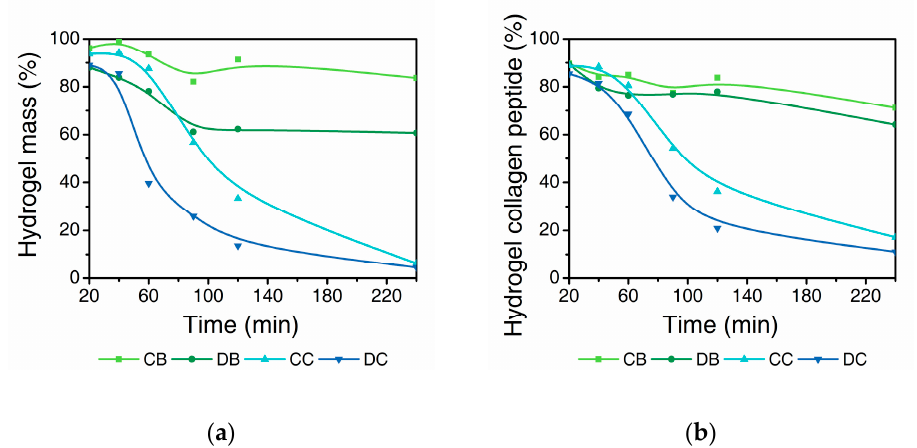
Figure 2. Degradation profile of collagen hydrogels. ( a ) Hydrogel mass remaining based on weight of the supernatant and ( b ) collagen peptide remaining based on hydroxyproline detected in the supernatant. CB and CC represent C-coll hydrogels in buffer and collagenase solution, respectively, while DB and DC represents D-coll hydrogels in buffer and collagenase solution, respectively. Results from one independent experiment (n = 1) are fitted with B-spline to highlight the change in the rate of degradation.